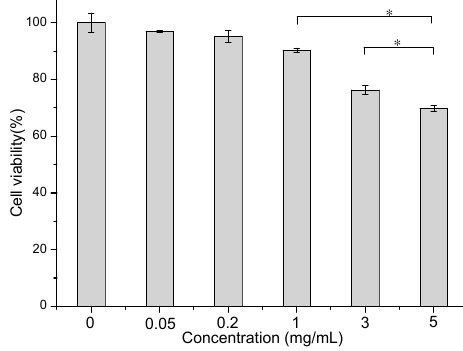
Figure 8. In vitro cytotoxicity after incubation with SA-BSPs copolymer micelles (* p < 0.05).